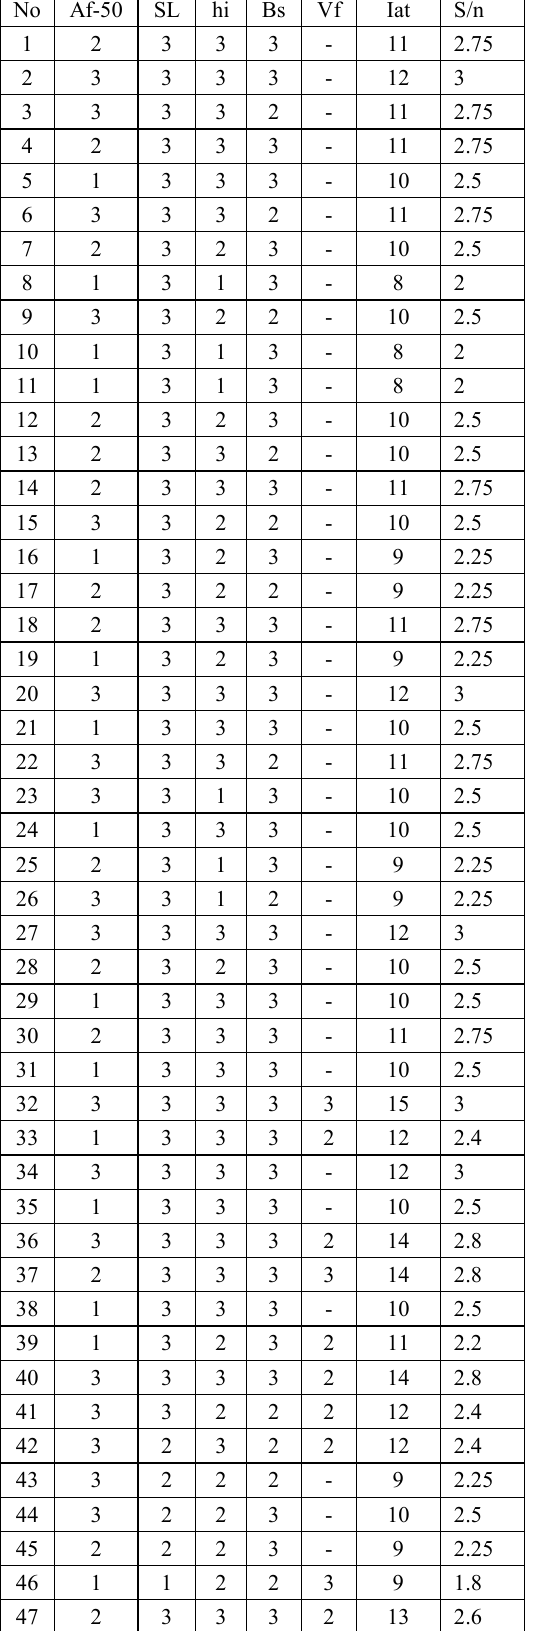
Table 1. Classification of the Iat (relative tectonic activity index) in the Valapattanam river